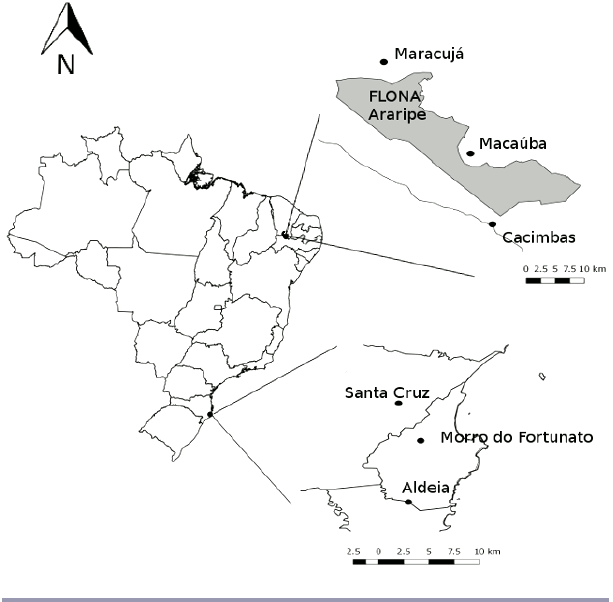
Fig. 1 . Study area showing the three rural communities of Chapada do Araripe, northeastern Brazil (Macaúba, Cacimbas, and Maracujá) and the three coastal Quilombola communities, southern Brazil (Morro do Fortunato, Santa Cruz, and